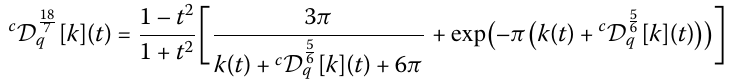
σ –2) (cid:12) q ( ζ ) in equation (62) for q = 1 (cid:12) q (